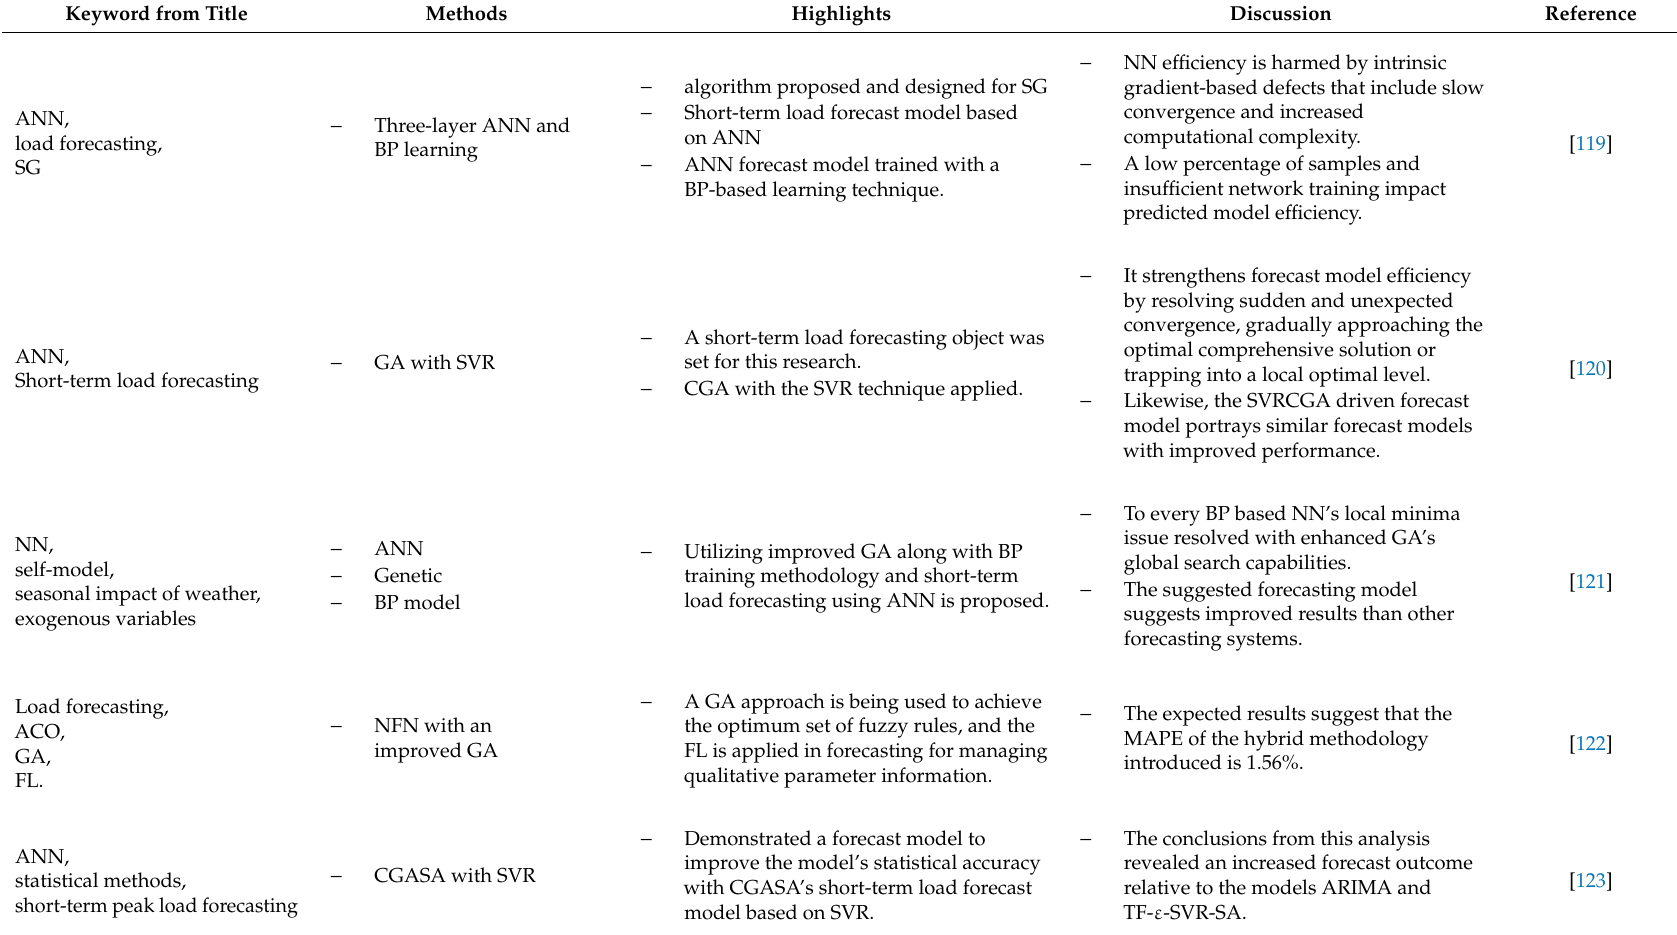
Table 2. The summary of the studied artificial intelligence techniques and their applications in a smart